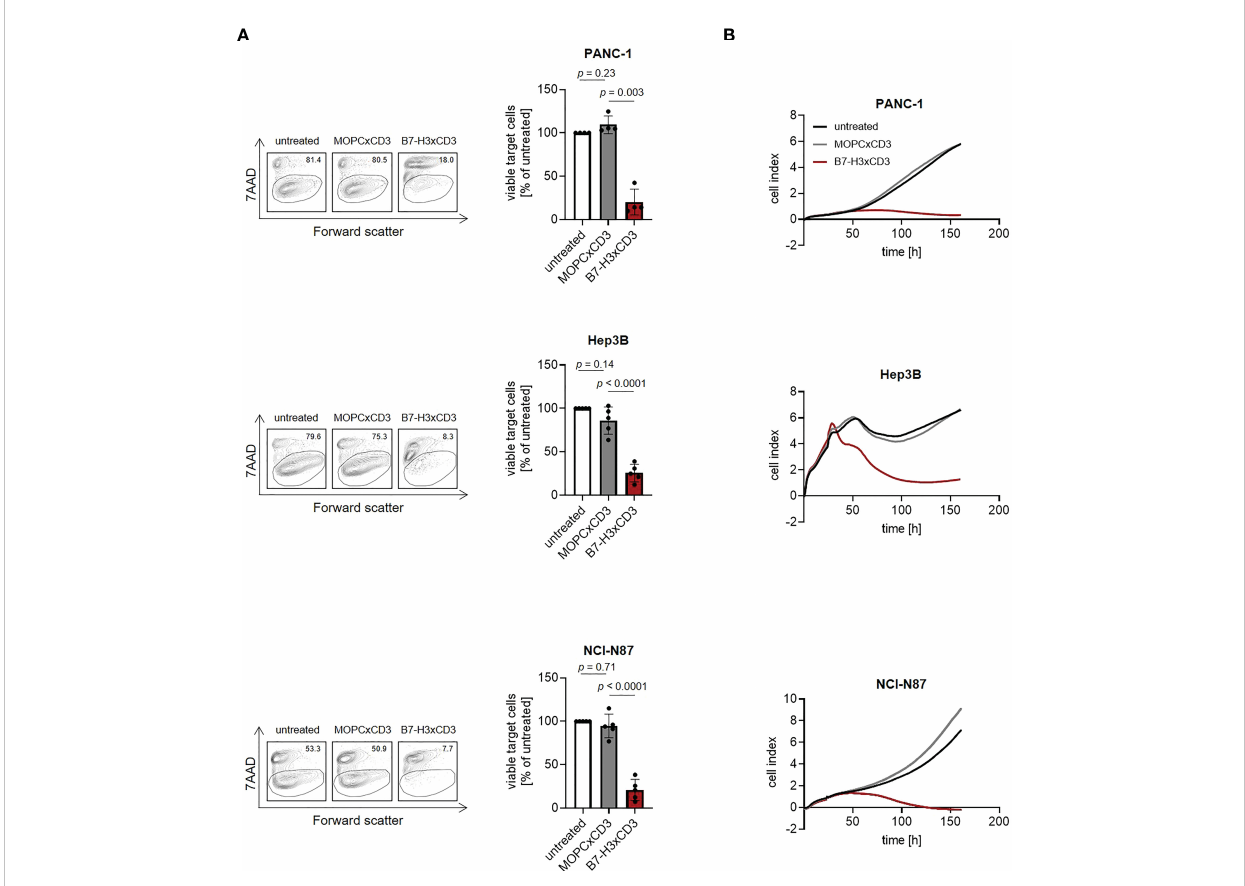
FIGURE 5 Induction of tumor cell lysis mediated by CC-3. Monocyte-depleted PBMC of healthy donors were incubated with the indicated target cells at an E:T ratio of 4:1 in the presence or absence of MOPCxCD3 or CC-3 (1 nM each). (A) Lysis of PANC-1, Hep3B and NCI-N87 cells was determined by fl ow cytometry-based lysis assay after 72 h. Left panels depict exemplary results right panels show combined data obtained with PBMC of fi ve independent donors. (B) Long-term cytotoxic effects of PBMC of healthy donors (n=4) against PANC-1, NCI-N87 and Hep3B cells was determined using xCELLigence system. E:T, effector to